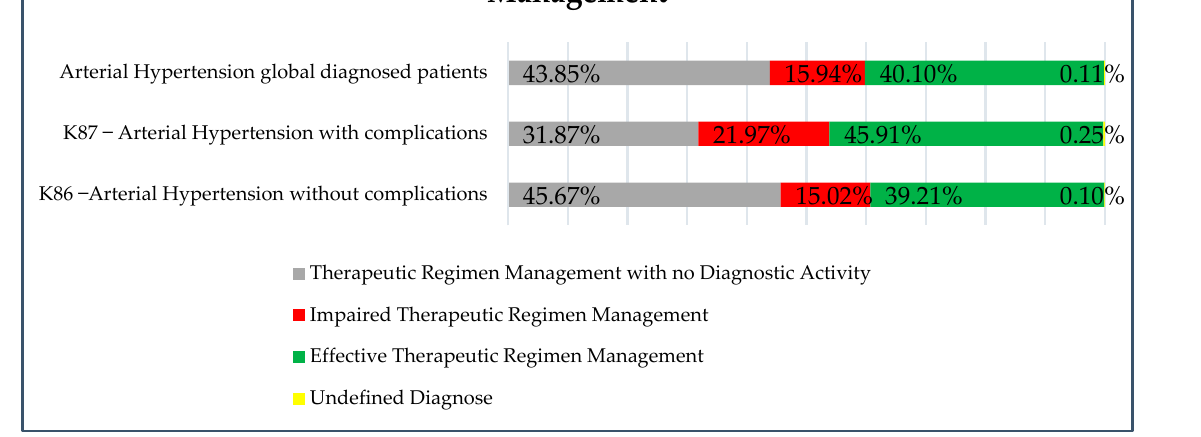
Figure 3. Distribution of nursing diagnosis activity in Therapeutic Regimen Management.